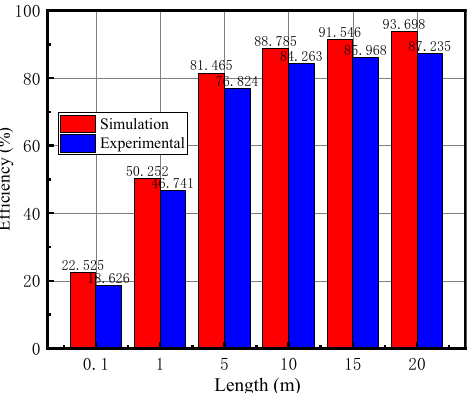
Figure 13. Comparison of simulation and experimental data under different lengths of transfer structure.